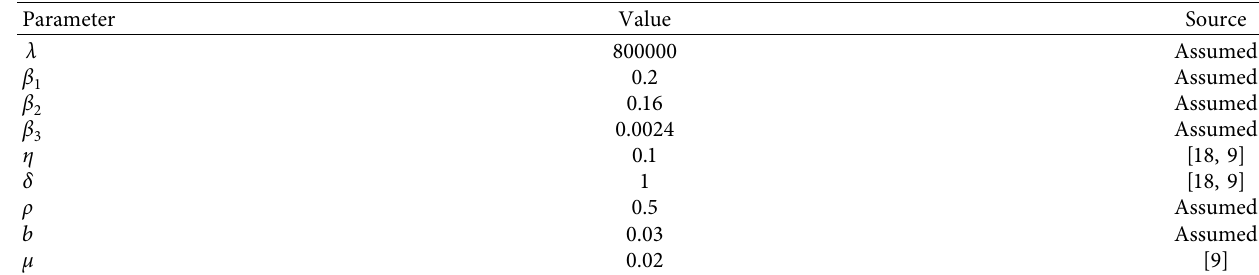
Table 2: Parameter and value assigned.